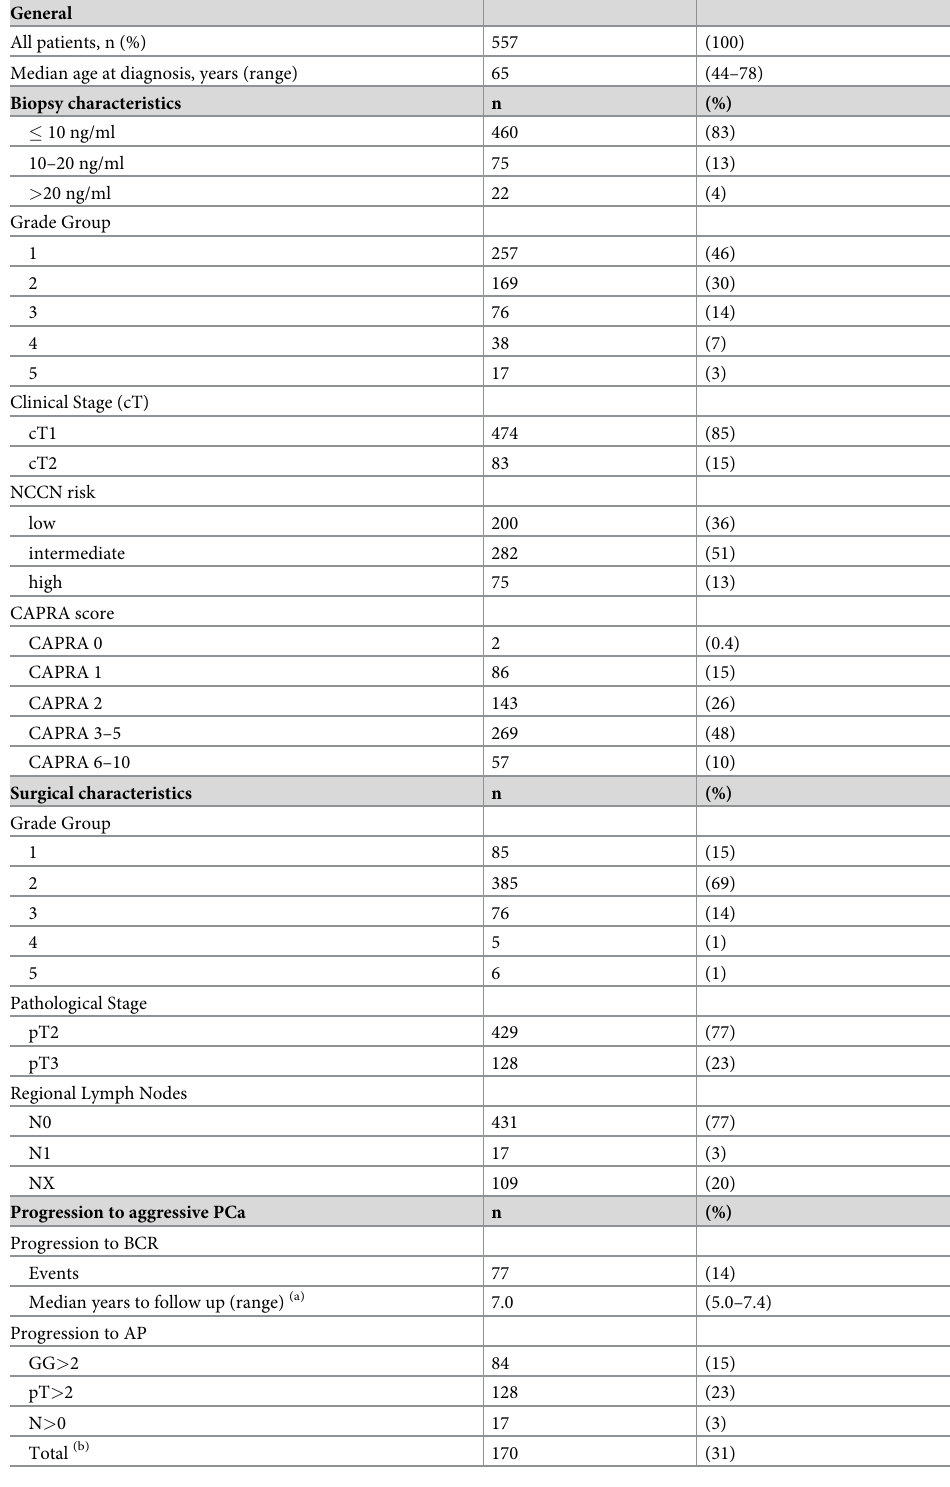
Table 1. Clinical characteristic of the